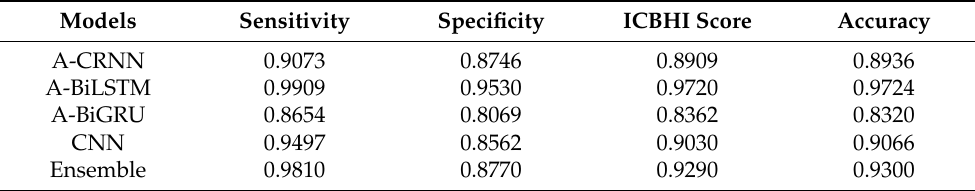
Table 20. Results of base and ensemble models for D4, i.e., the Coswara breathing dataset.